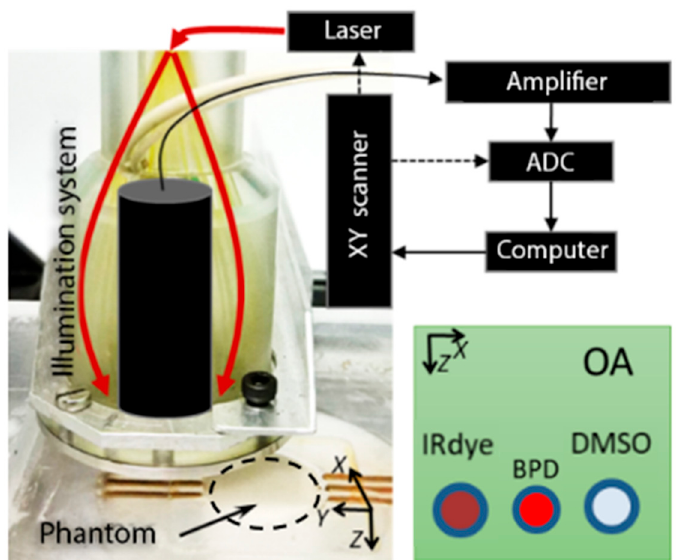
Figure 3. The schematic of the optoacoustic (OA) setup and a phantom with three embedded tubes.